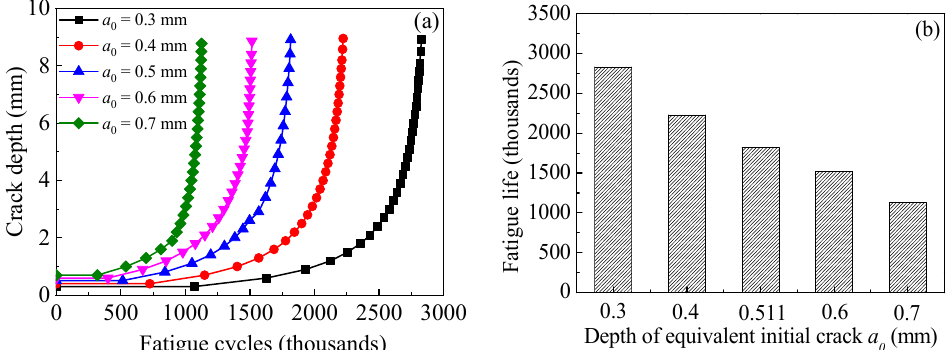
Figure 20. Effect of equivalent initial crack size on ( a ) the crack propagation curves and ( b ) the fatigue life of the corroded steel plate strengthened with CFRP plates.